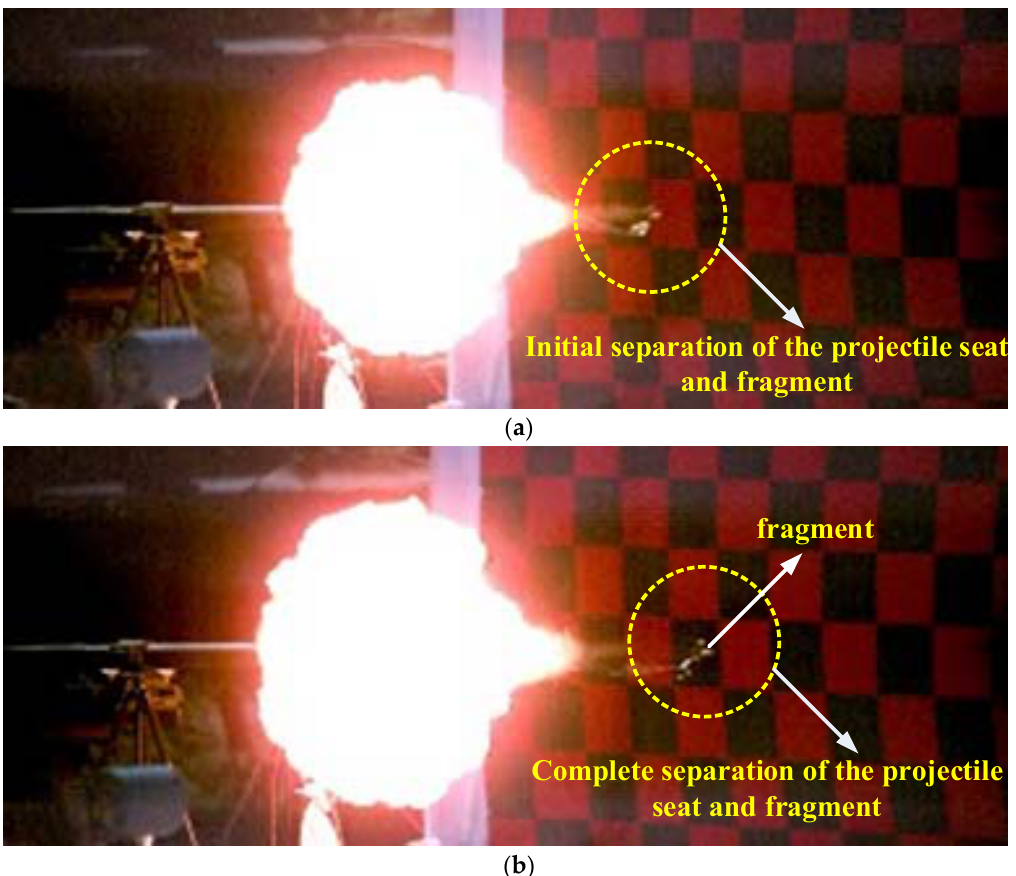
Figure 6. Movement process of the projectile. ( a ) t = 1.2 ms; ( b ) t = 1.4 ms.